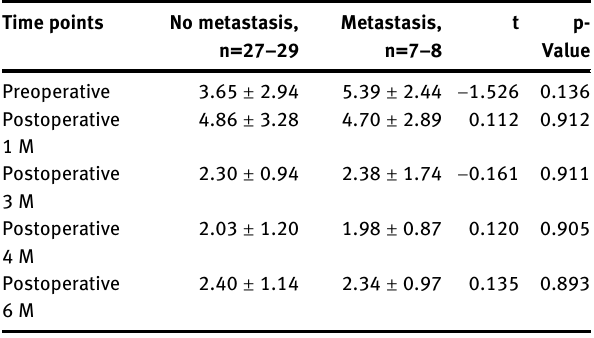
Table  : Association between NLR levels (%) and postoperative